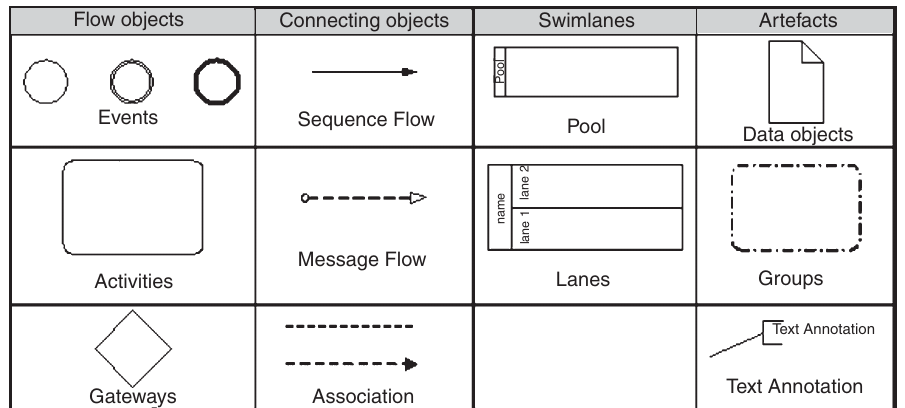
Fig. 1. BPMN diagram